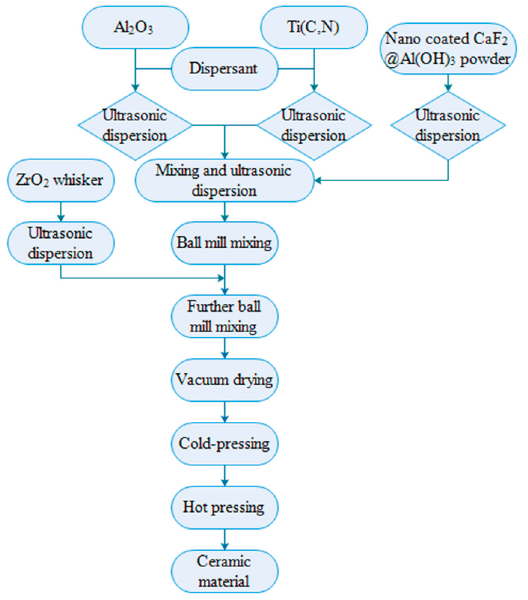
Figure 1. The flow chart of the composite ceramic material preparation.